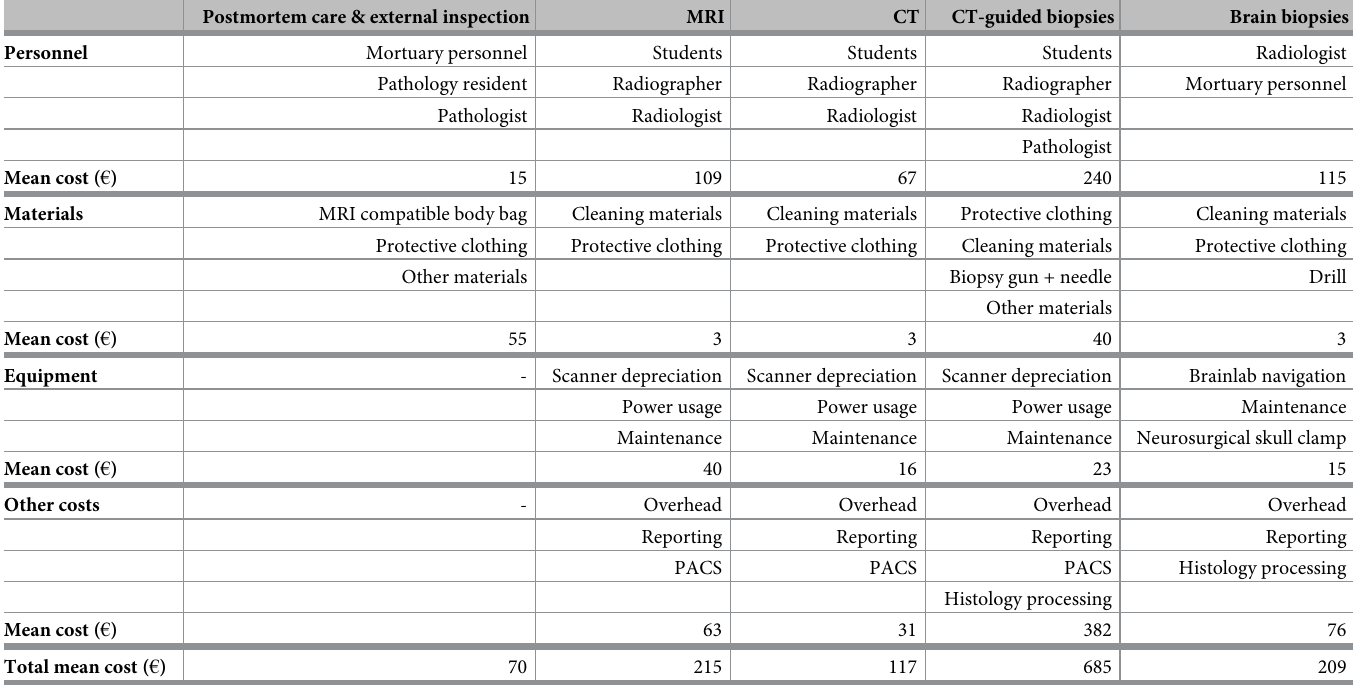
Table 5. Costs of minimally invasive